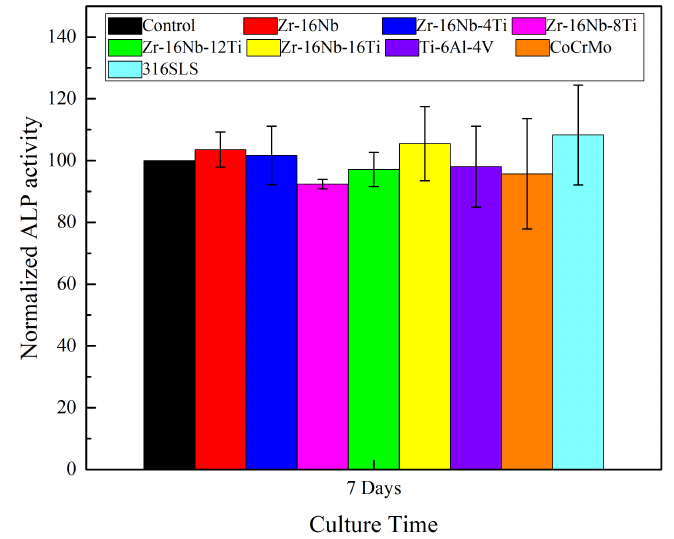
Figure 9. MG 63 cells lysates normalized alkaline phosphatase (ALP) activities after cell cultivating in extracts of Zr-16Nb-xTi, Ti-6Al-4V, Co-Cr-Mo and 316L SS alloys for 7 days.